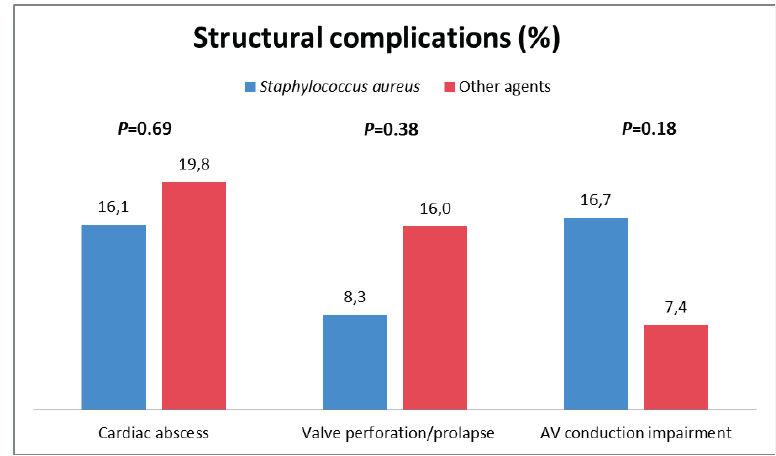
Fig. 1. Structural complications.